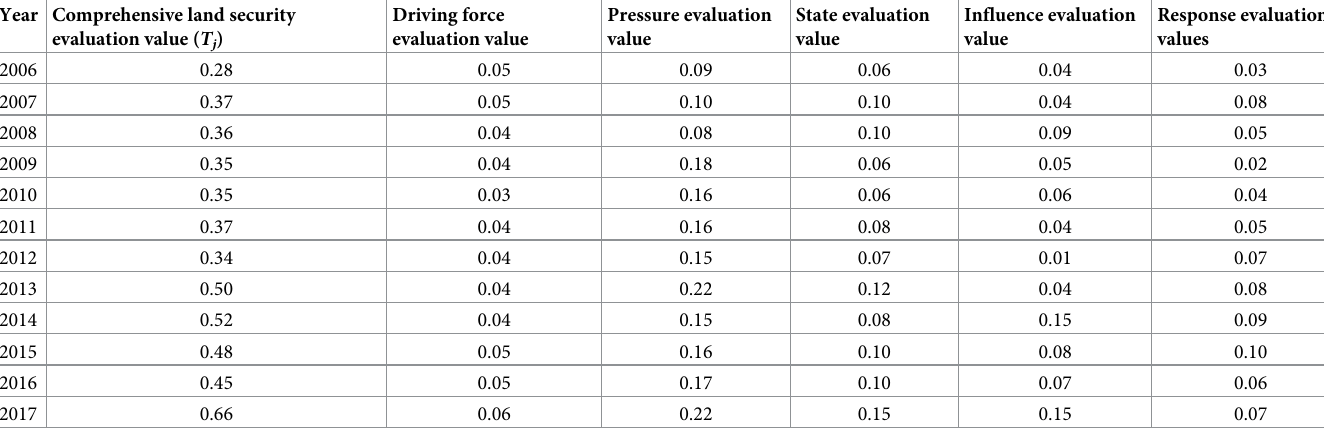
Table 11. Land-based ecological security evaluation index values in Xingtai city from 2006 to